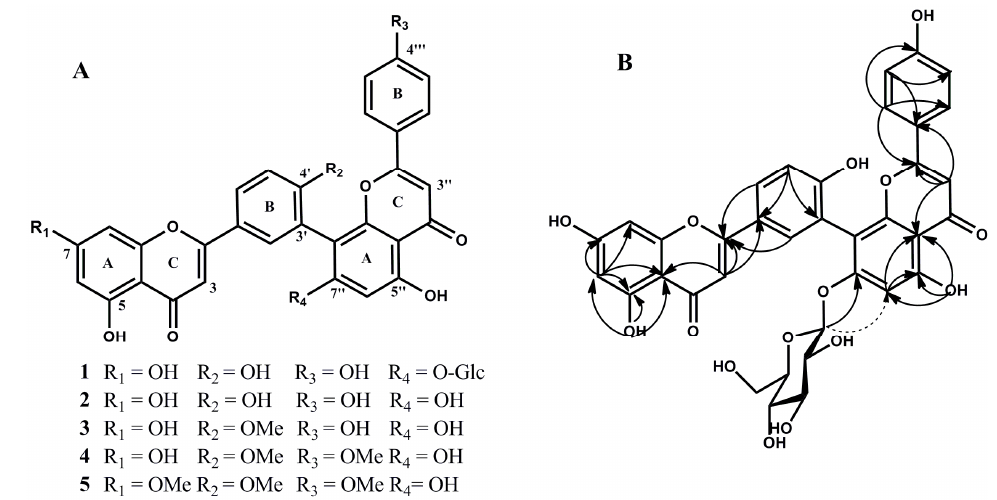
Figure 1. Structures of compounds 1 – 5 ( A ). Key heteronuclear multiple bond correlation (HMBC) correlations ( ) and nuclear overhauser enhancement spectroscopy (NOESY)correlations ( ) of compound 1 ( B ).